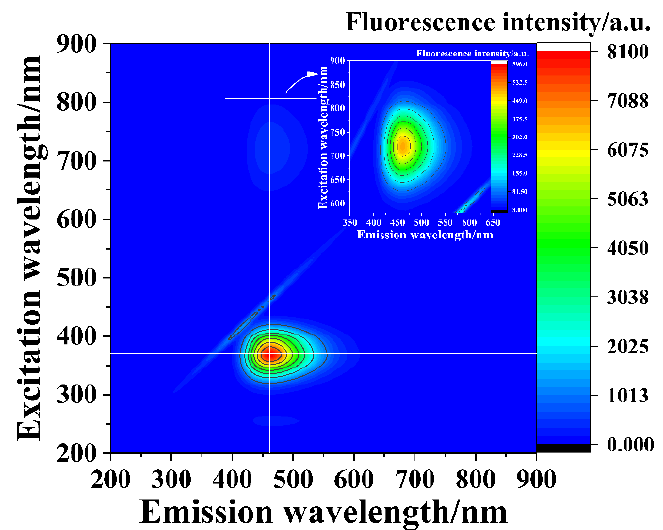
Figure 4. Excitation–emission map of the as ‐ prepared SiNPs.